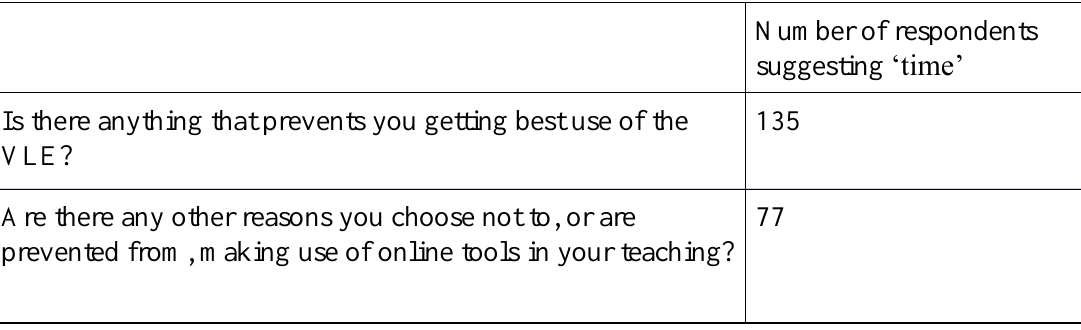
Table 2: Time as a factor